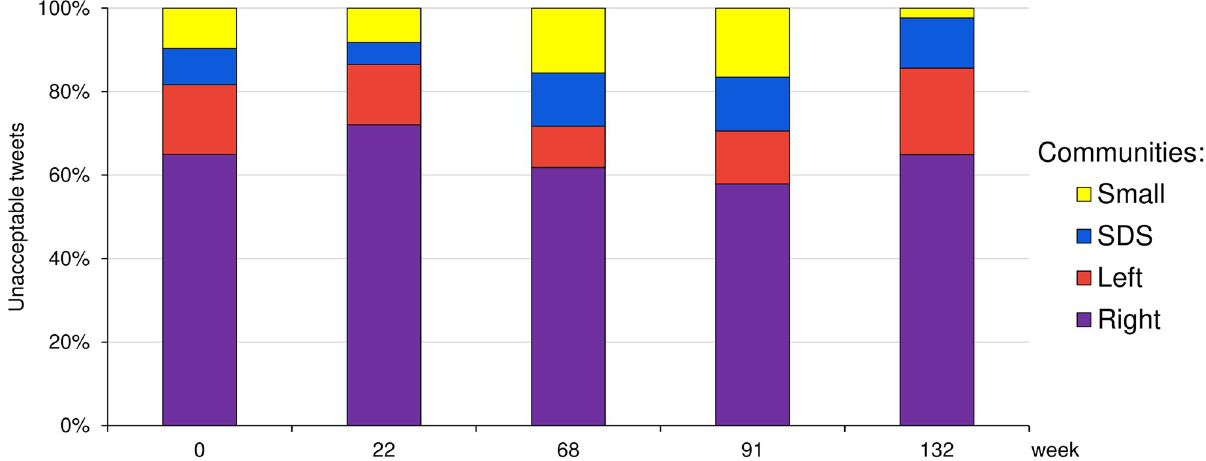
Fig 4. Distribution of posted unacceptable tweets between the three major communities through time. Left is the largest, left-leaning community, two right-leaning communities are Right and SDS, and Small denotes all the remaining smaller communities. Weekly timepoints are marked by t = 0, 22, ... , 132. The Right community posts the largest share of the unacceptable tweets, over 60% at four out of five timepoints. The Left and SDS communities are comparable, each with the share of about 10–20% of all unacceptable tweets